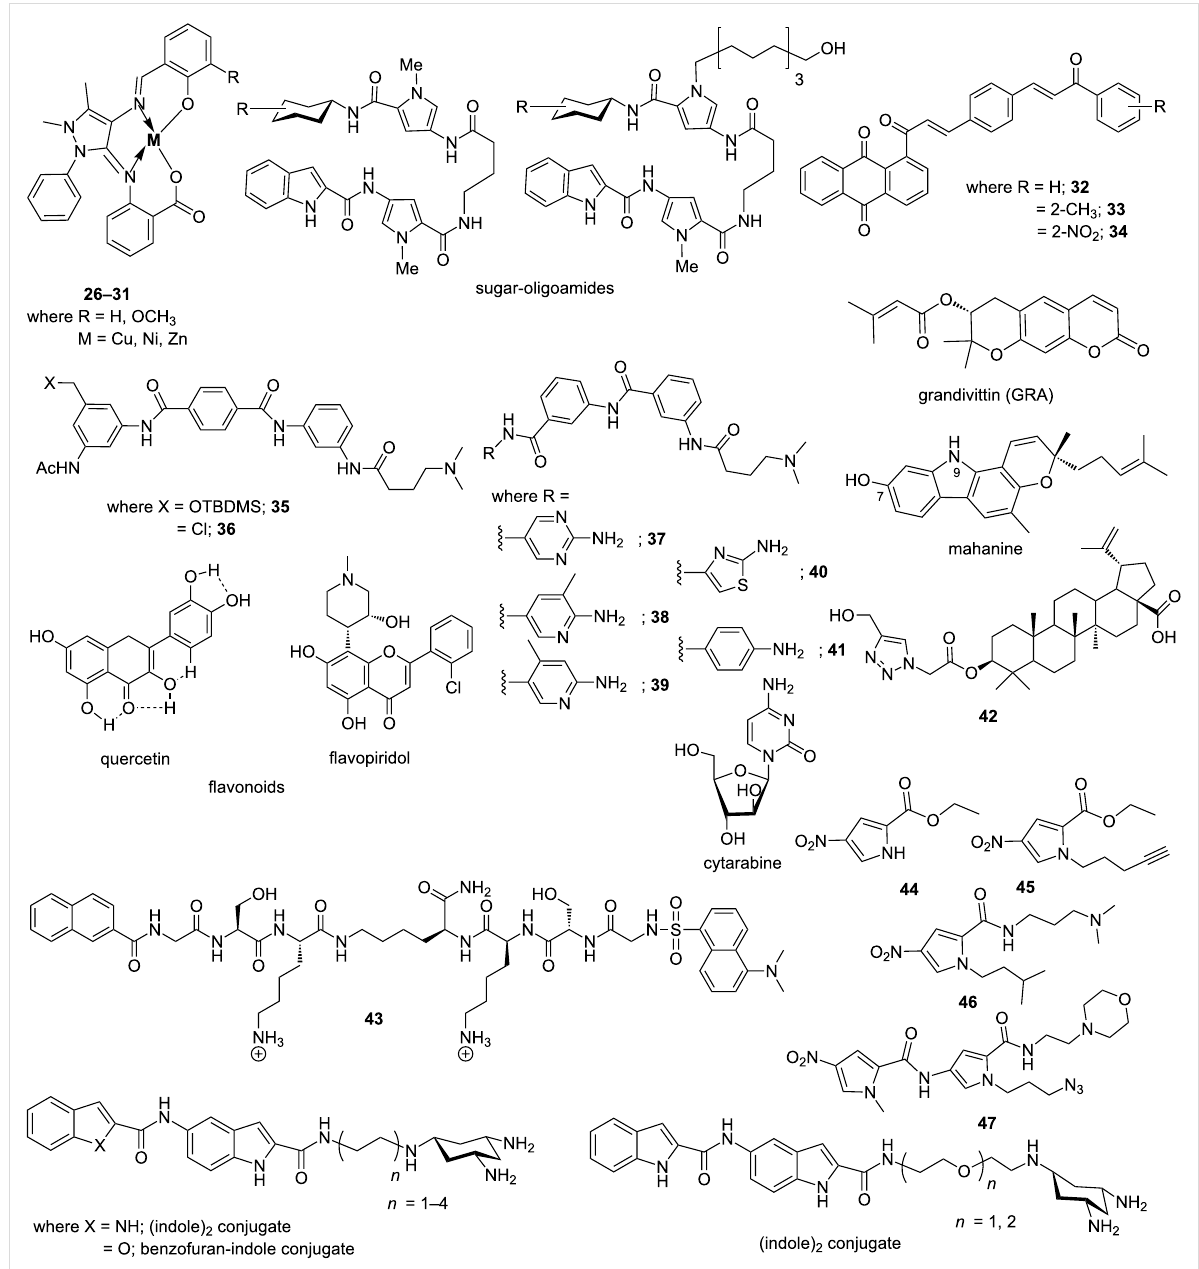
Figure 9: Representative examples of recently developed DNA minor groove binders.